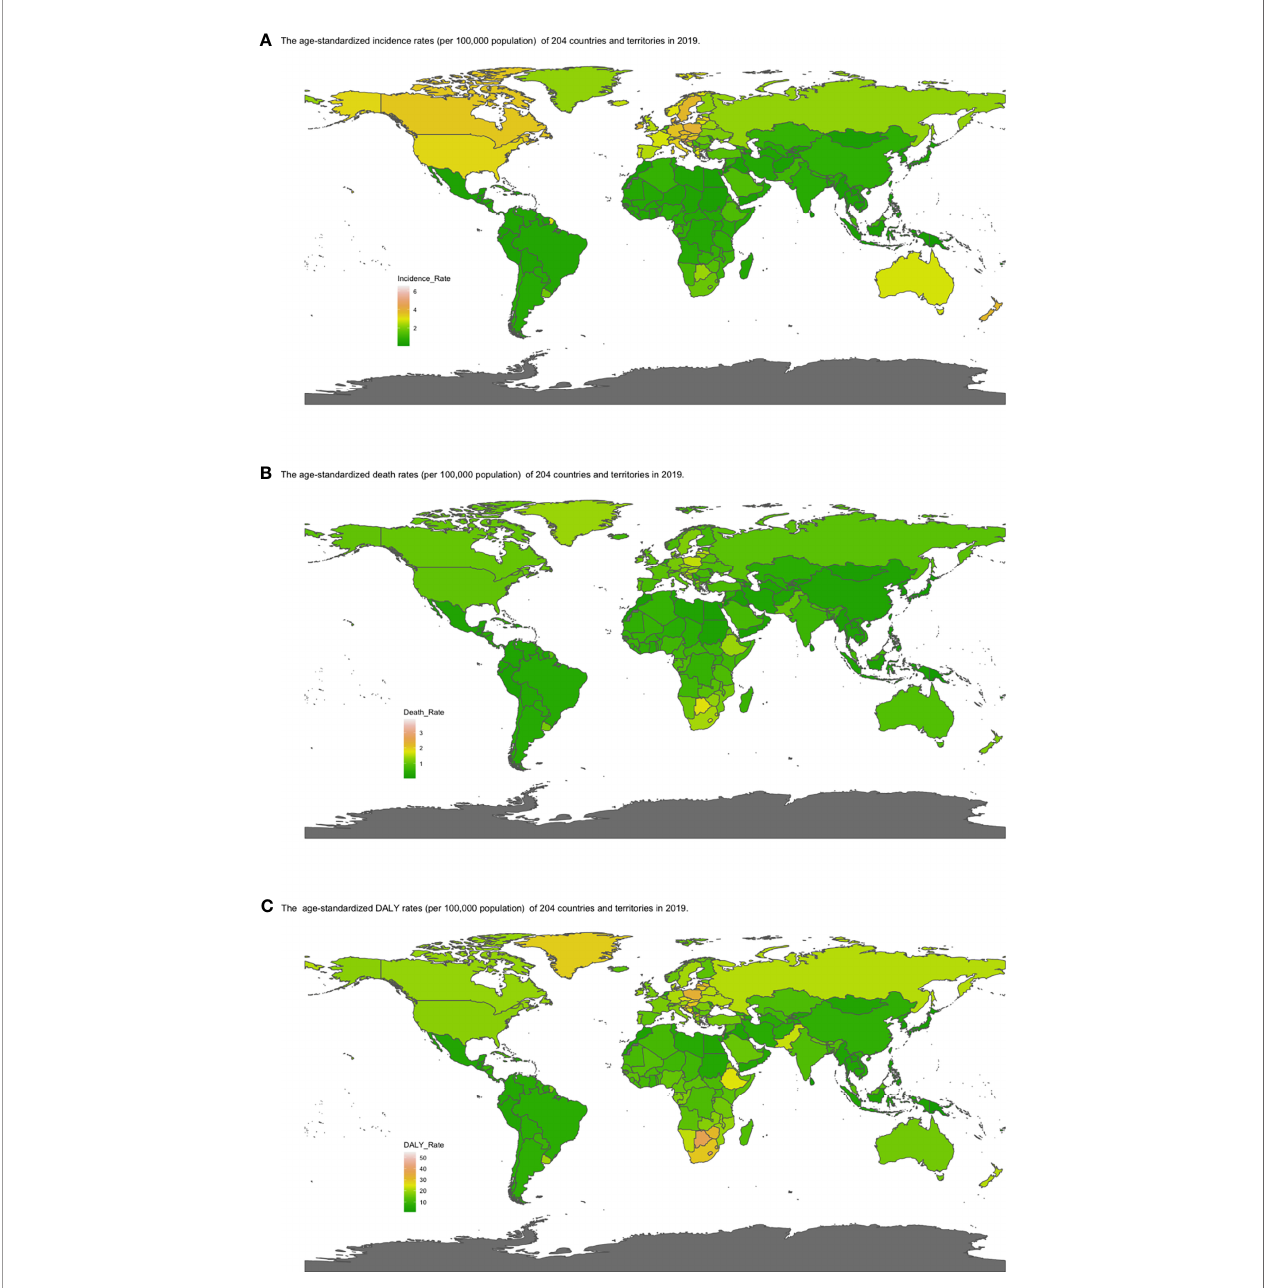
FIGURE 4 | Map of (A) ASIR, (B) ASDRs, and (C) age-standardized DALY rates by country in 2019. Heat gradient represents age-standardized rates from pink (highest) to dark green (lowest). (ASIR, age-standardized incidence rate; ASDR, age-standardized death rate; DALY, disability-adjusted life year; EAPC, estimated annual percentage